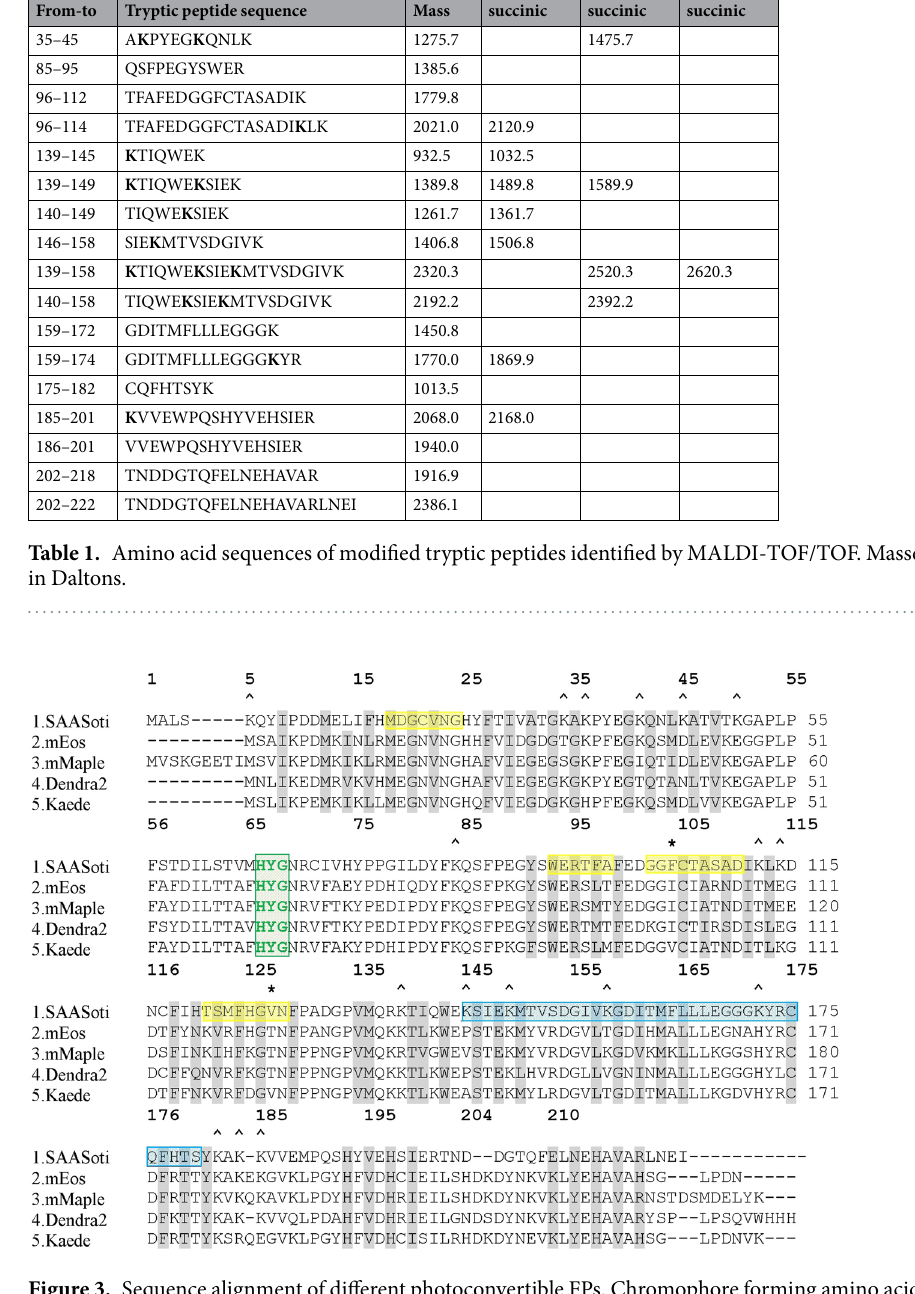
Two-Focus Fluorescence Correlation Spectroscopy (2fFCS) is one of the most sensitive methods for study- ing protein diffusion 36 . Based on a modified fluorescence correlation spectroscopy (FCS)-setup, this method is improved by introducing an external ruler for measuring the diffusion time by generating two laterally shifted and overlapping laser foci at a fixed and known distance. Calculation of the diffusion coefficient is done by ana- lyzing the measured 2fFCS autocorrelation function G ( t , δ ) using triple state model. Using 2fFCS, we calculated diffusion coefficients of D = 68 ± 1 µ m 2 /s for SAASoti (K145E) and 72 ± 1 µ m 2 /s for wild type SAASoti. The data obtained is consistent with the diffusion coefficient of a tetramer 37 or an even larger oligomer (Supplementary Fig. S5). The diffusion coefficient for V127T SAASoti was estimated to be equal to D = 93 ± 1 µ m 2 /s (Fig. 4) and is little bit less than measured value 117 ± 2 µ m 2 /s and previously published 97 µ m 2 /s for eGFP measured by FCS 37 .